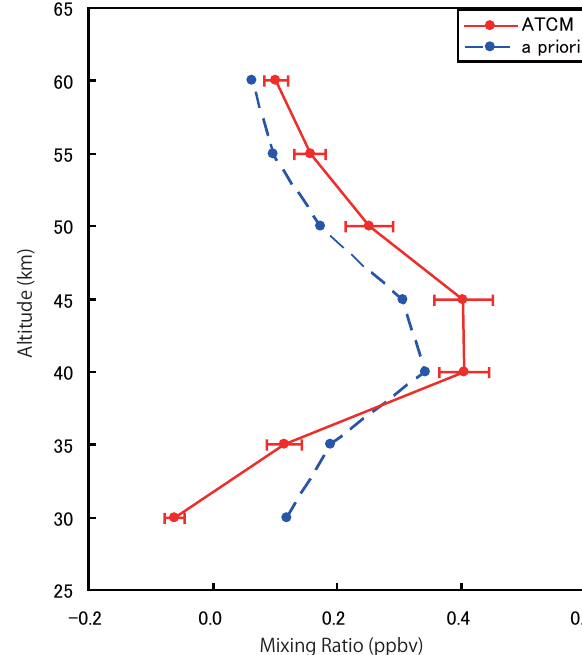
Fig. 4. Vertical profile of ClO mixing ratio retrieved from the av- eraged spectrum obtained at 12:00–15:00LT from 5 to 16 Decem- ber 2009 (red solid line) and a priori profile (blue dashed